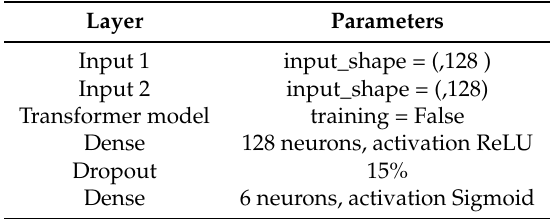
Table 3. Architecture of the pre-trained transformer